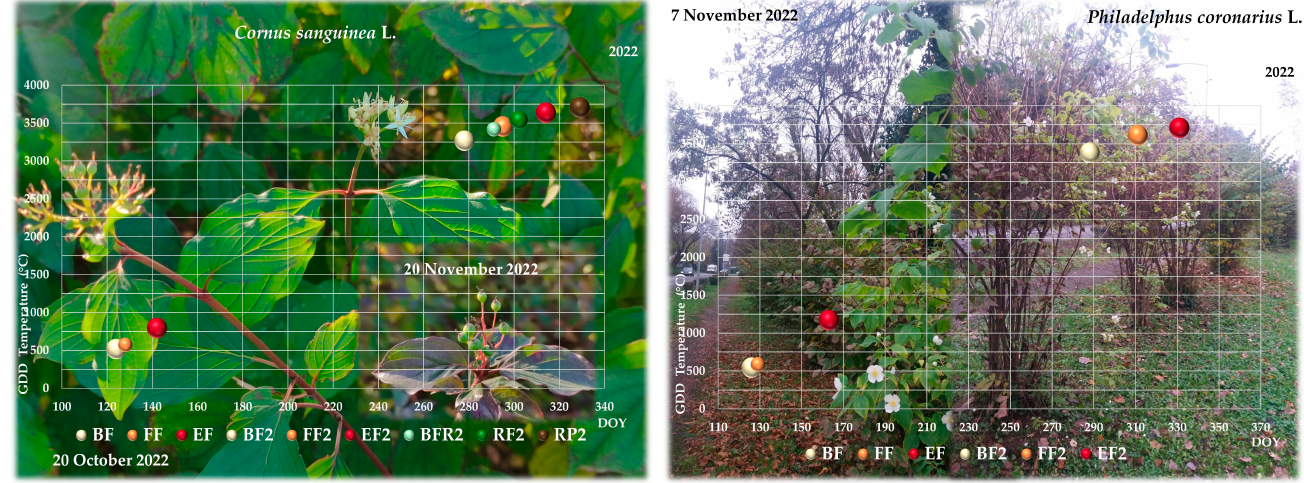
Figure 13. Phenological observations: GDD and DOY for the beginning of first flowering (BF), full first flowering (FF), the end of first flowering (EF), the beginning of second flowering (BF2), full second flowering (FF2), the end of second flowering (EF2), RF2 (second appearance of first ripe fruits), and RP2 (second fruit ripening) for Common Dogwood (left) and European Mock-Orange (right) in 2022.